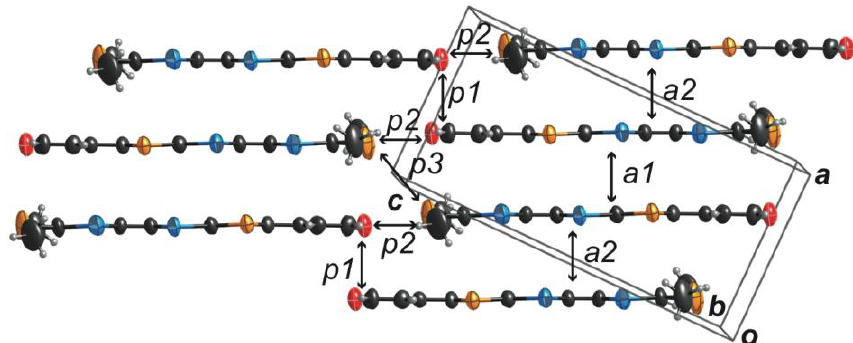
Figure 8. Donor sheet structure of (TM-PDS-STP)PF molecular short axis. The calculated intermolecular overlaps between HOMO-1s (× 10 −3 ) are a1 = 16.0, a2 = 7.3, p1 = 1.1, p2 = −2.2, and p3 =